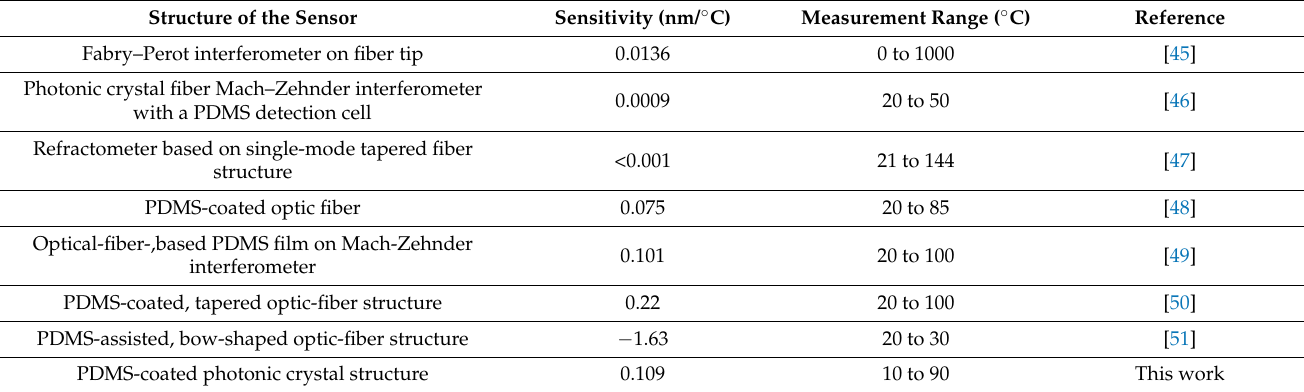
Table 1. Comparison of the proposed work with the existing